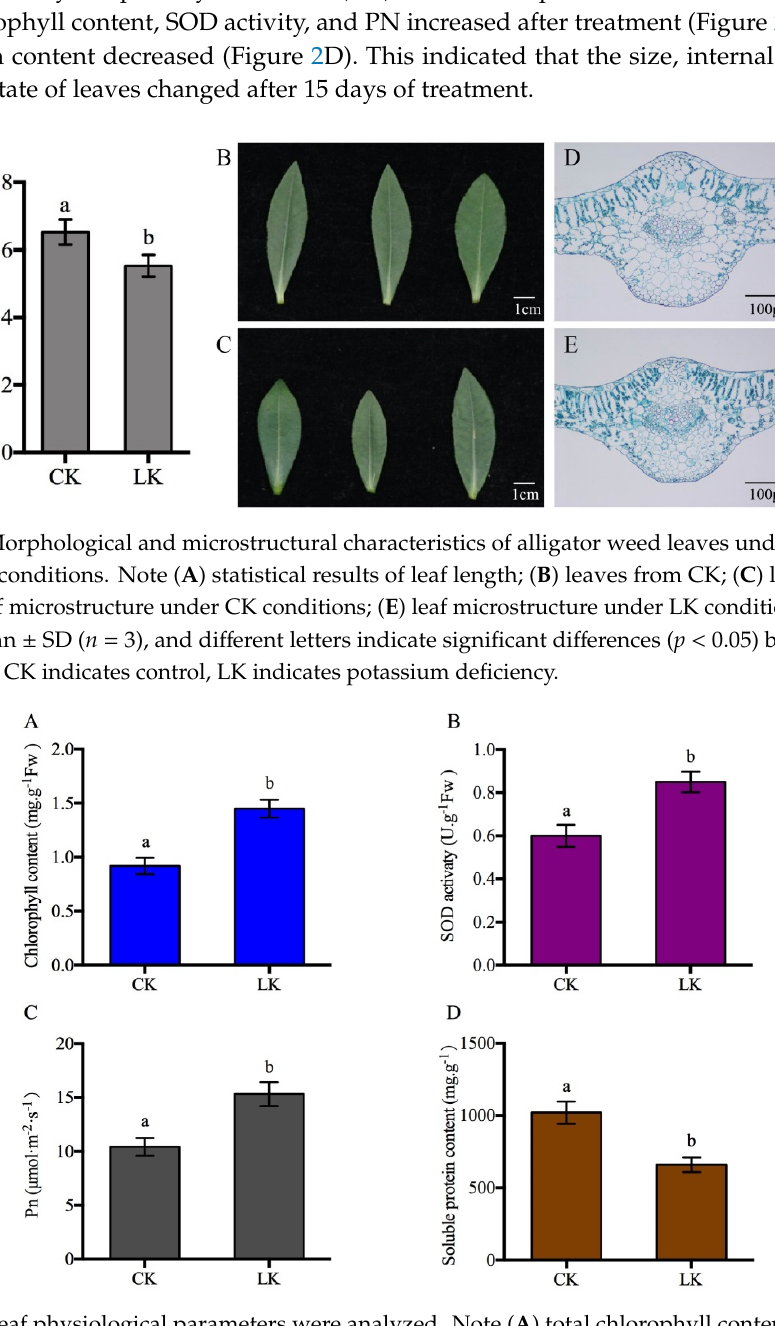
Figure 2. Leaf physiological parameters were analyzed. Note ( A ) total chlorophyll content; ( B ) SOD activity; ( C ) net photosynthetic rate; ( D ) soluble protein content. Values are the mean ± SD ( n = 3), and different letters indicate significant differences ( p < 0.05) between the treatments, CK indicates control, LK indicates potassium deficiency.